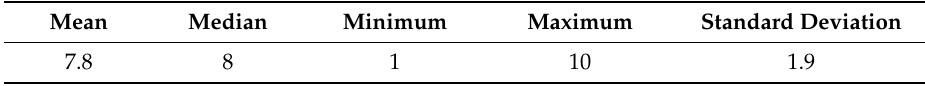
Table 2. Study of the level of intensity of the motivation to undertake physical activity (PA) due to cheering in the 6th Poznan Half Marathon.